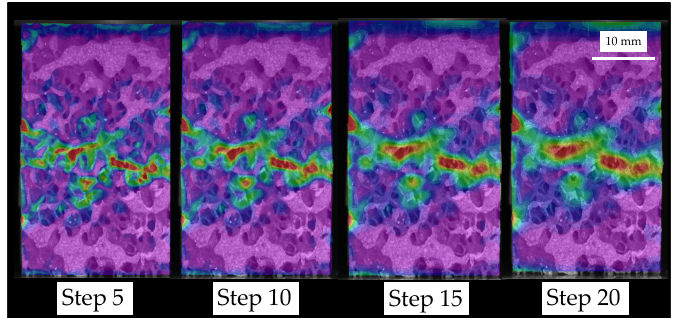
Figure 10. Influence of step size variation between 5 and 20 pixels on the equivalent strain field for a HD specimen. A similar influence was observed for MD and LD specimens.